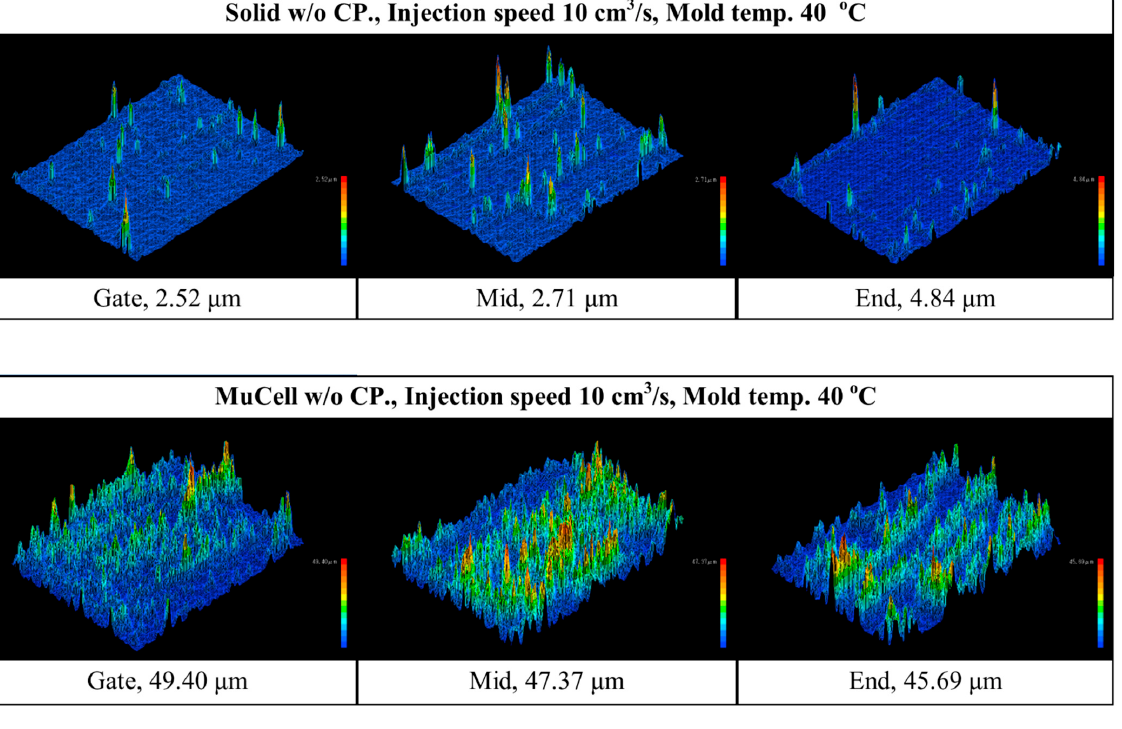
Figure 7. Surface roughness measurement at gate, mid, and flow end positions both for solid and microcellular molding without GCP. Table 3. Surface roughness measurements with different GCP and holding times on the middle